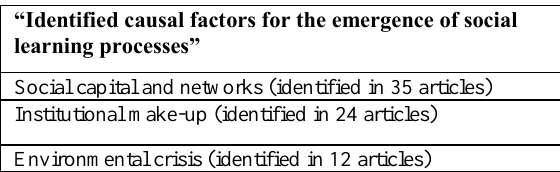
Appendix Table 3: Causal factors identified in Siebenhüner et al. 2016 “Identified causal factors for the emergence of